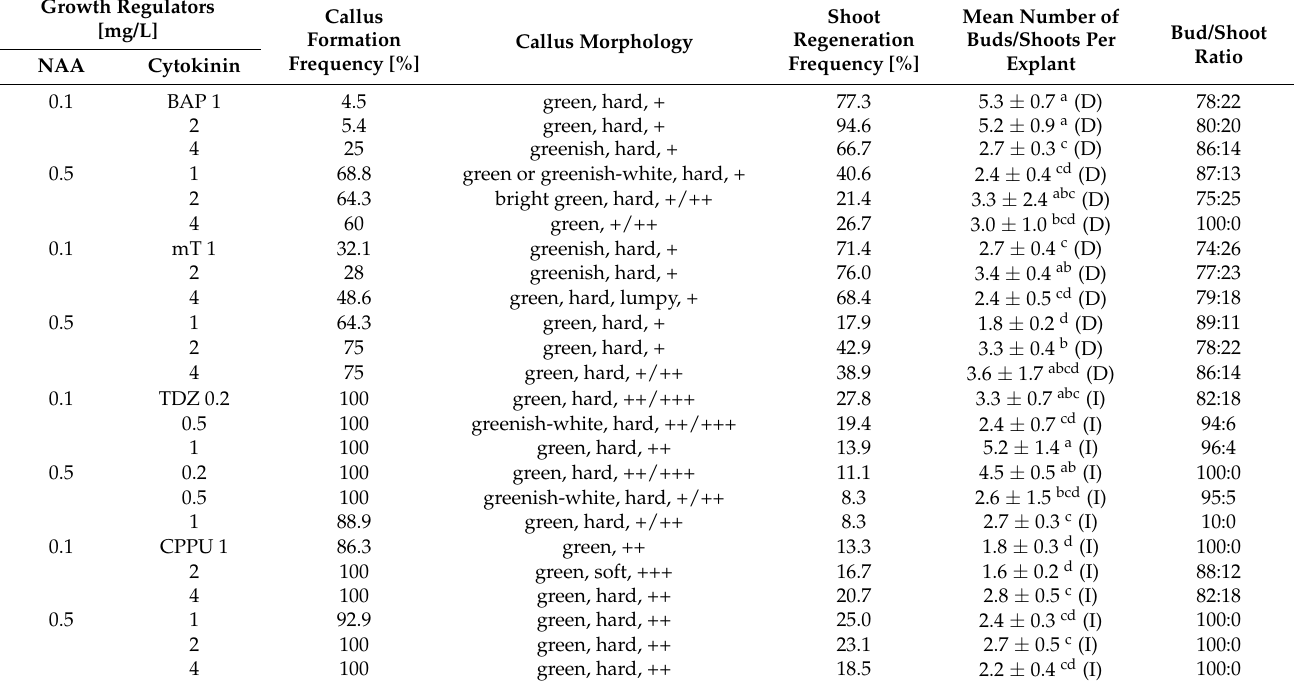
Table 2. Effect of growth regulator combination on shoot organogenesis of S. bulleyana from leaf explant. Growth Regulators